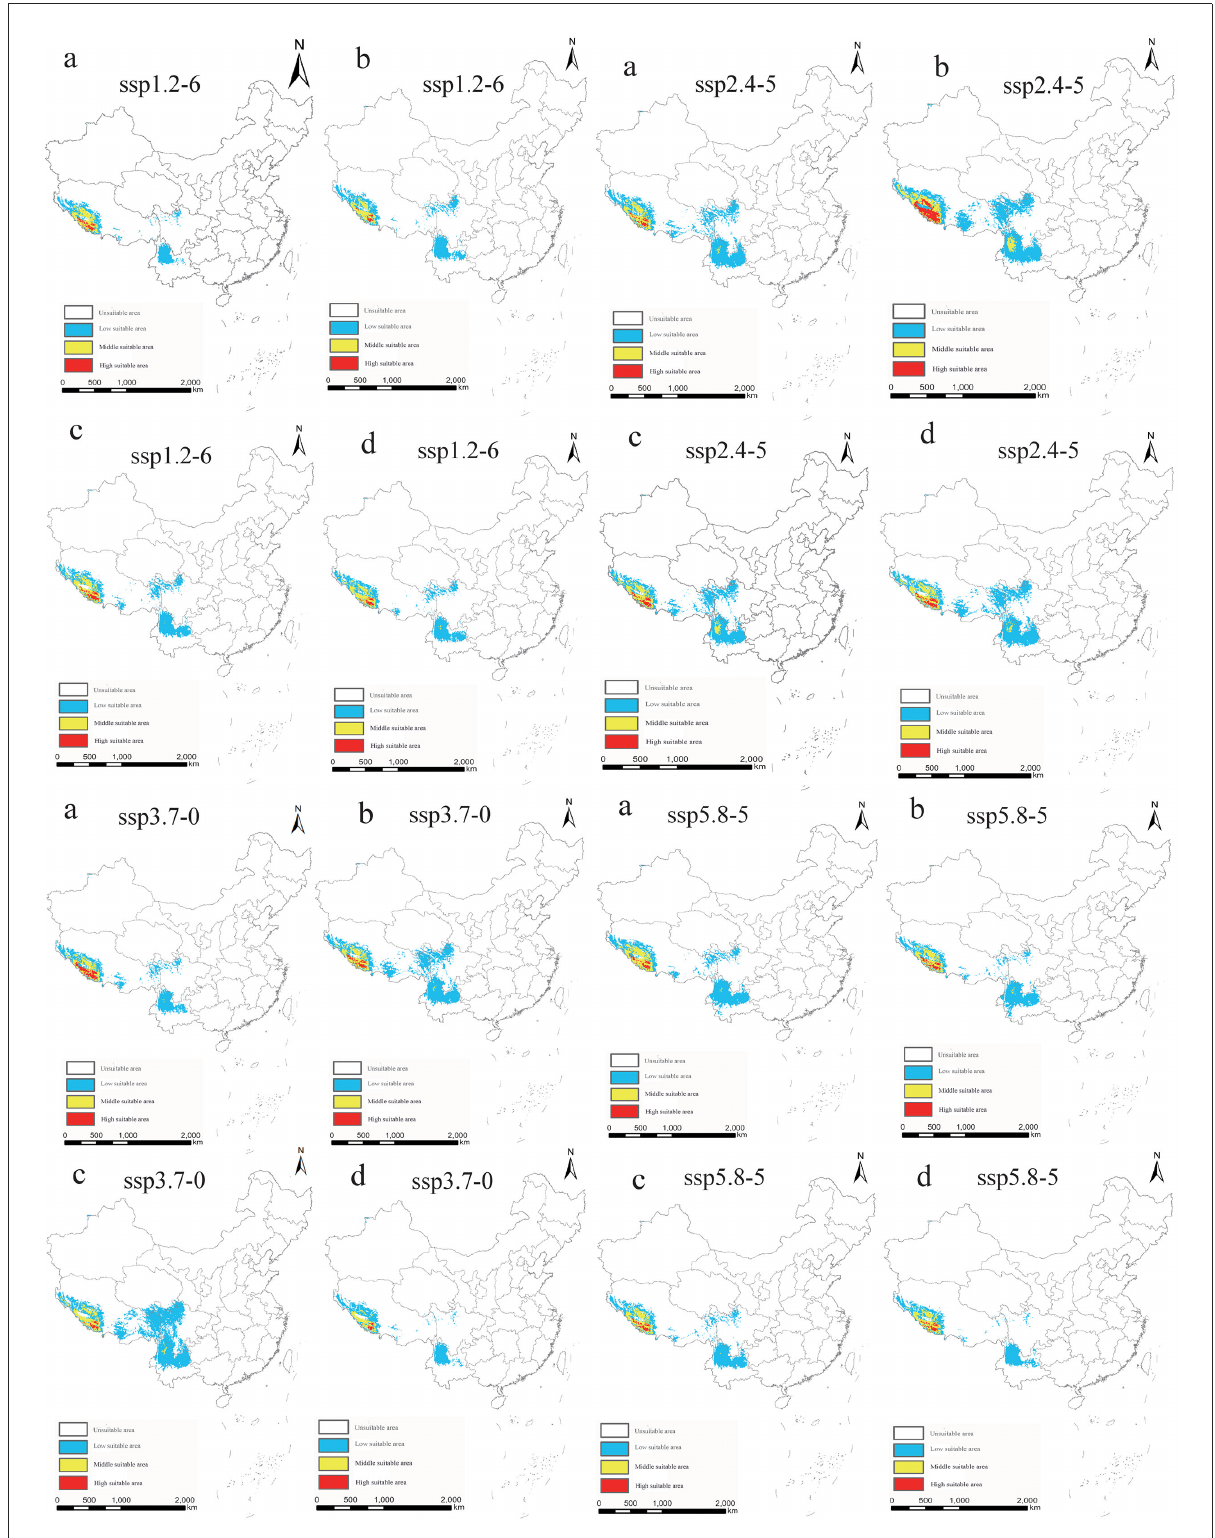
FIGURE7 Suitable areas in China for O. sexdentatus under different future climate scenario models (a: 2021–2040, b: 2041–2060, c: 2061–2080, and d: